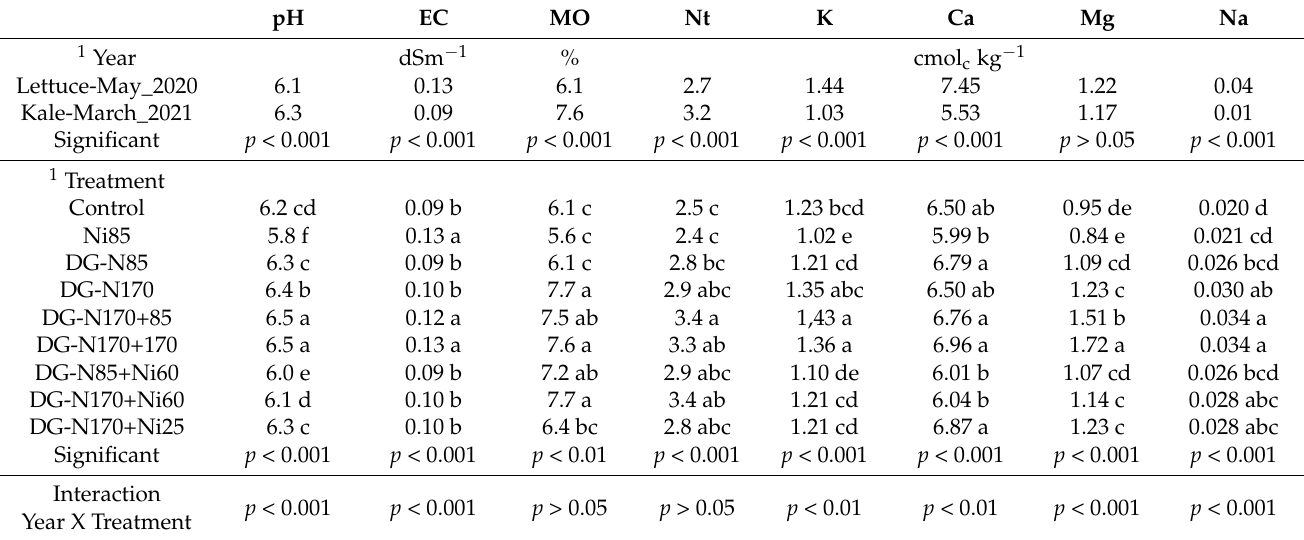
Table 5. Changes in the soil properties after the lettuce and the kale crop cycles obtained by the ANCOVA